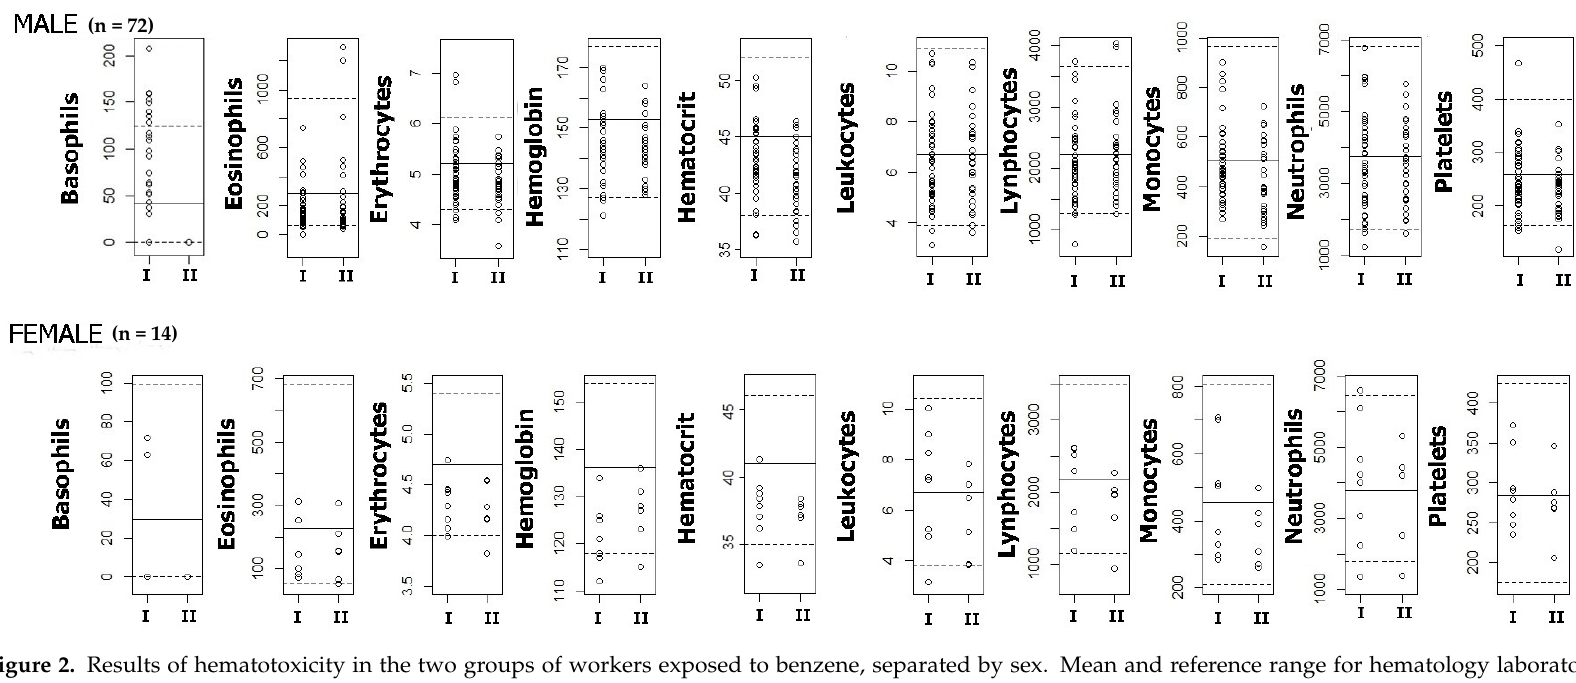
Figure 2. Results of hematotoxicity in the two groups of workers exposed to benzene, separated by sex. Mean and reference range for hematology laboratory counts: Basophilis ( × 10 6 L − 1 ): women 29.6 (0–99) and men 41.7 (0–125); Eosinophilis ( × 10 6 L − 1 ): women 228.5 (56–682) and men 284.6 (65–940); Erythrocytes ( × 10 12 L − 1 ):women 4.7 (4.0–5.4) and men 5.2 (4.3–6.1); Hematocrit (L L − 1 ): women 0.41 (0.35–0.46) and men 0.45 (0.38–0.52); Hemoglobin (g L − 1 ): women 136.2 (118–154) and men 152.8 (127–177); Leukocytes ( × 10 9 L − 1 ): women 6.7 (3.84–10.4) and men 6.7 (3.9–10.9); Lynphocytes ( × 10 6 L − 1 ): women 2175.3 (1157–3500) and men 2223.2 (1265–3648); Monocytes ( × 10 6 L − 1 ): women 455.1 (208–807) and men 503.2 (192–968); Neutrophils ( × 10 6 L − 1 ): women 3777.3 (1804–6460) and men 3762.7 (1728–6820); Platelets ( × 10 9 L − 1 ): 284.1 (175–421) and men 258.6 (163–399)